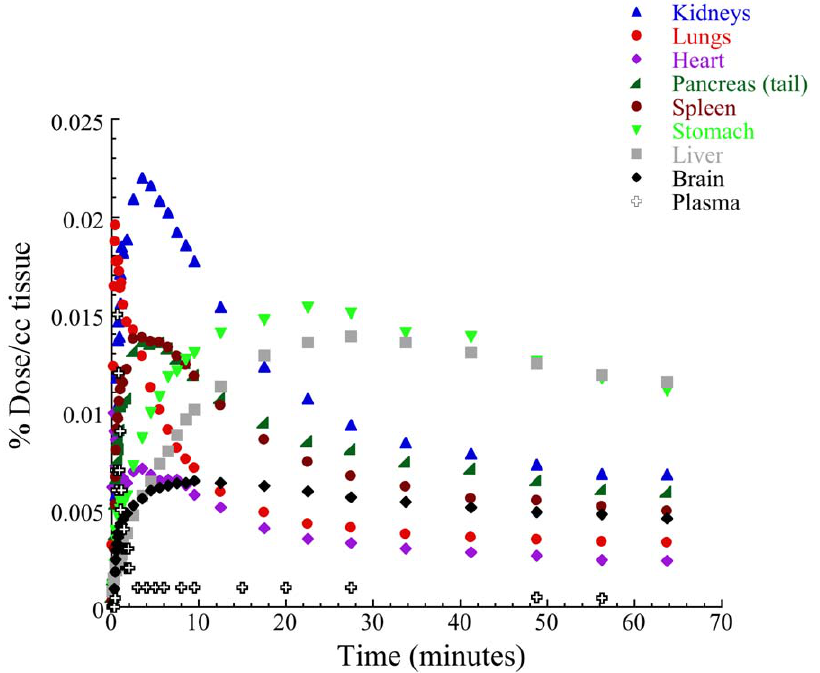
Figure 1. Averaged time-activity curves of [ 11 C]d-metamphetamine in the various organs of the body. Note that the values correspond to the average for all subjects (AA and C) whereas Table 2 reports separate values for AA and C, which is why they don’t exactly match.